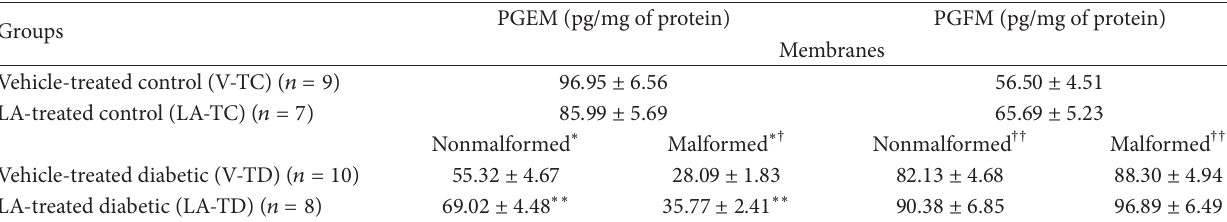
Table 10: PGEM and PGFM in membranes.